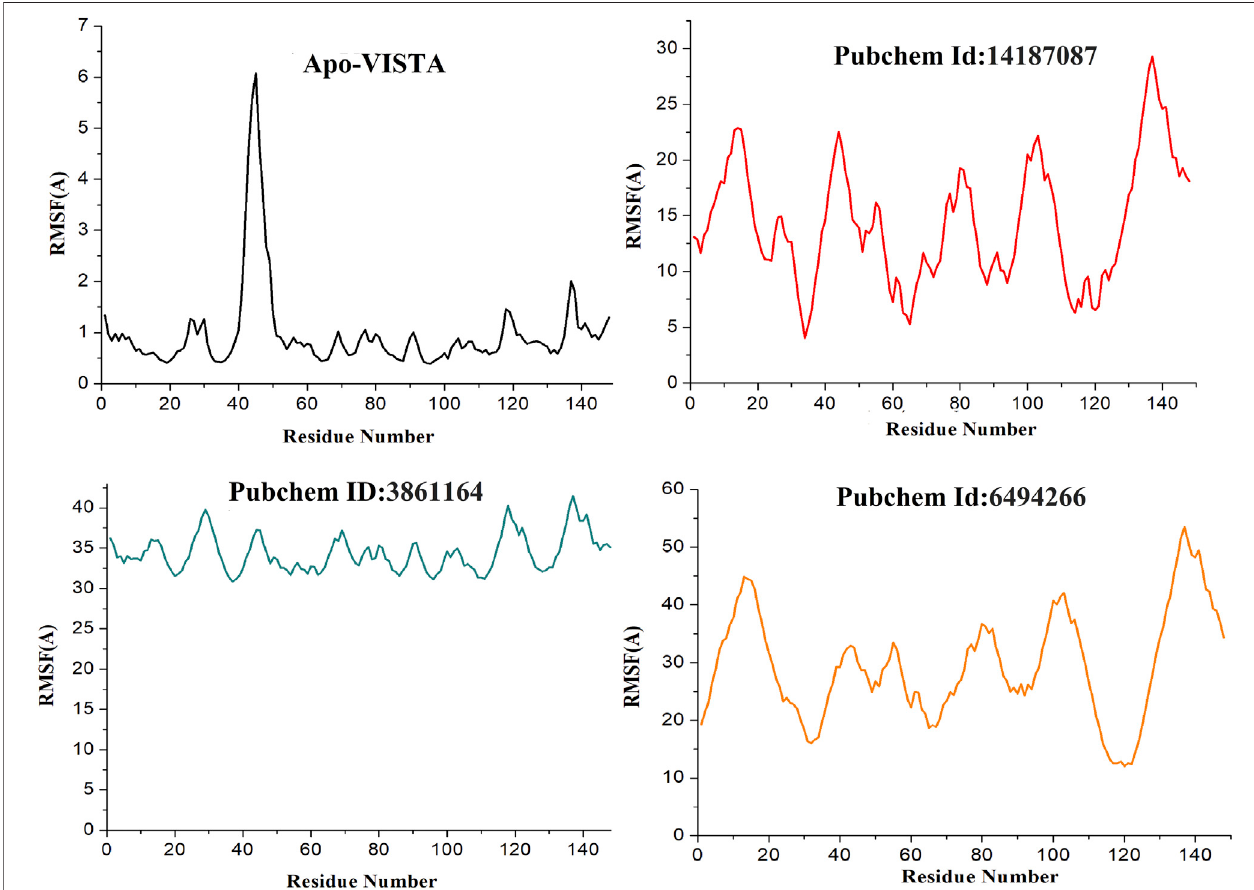
FIGURE 5 | RMSF of simulated systems. The protein residues (on the x -axis) are plotted versus their fl exibility (on the y -axis) from the mean position in simulation time (Apo-VISAT: black, PubChem ID: 14187087-VISTA: red, PubChem ID: 3861164-VISTA: green, and PubChem ID: 6494266-VISTA: orange).